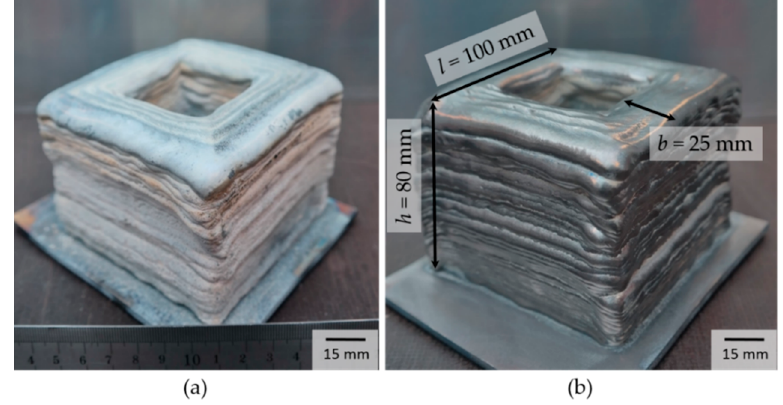
Figure 3. Manufactured part ( a ) as-welded condition ( b ) brushed condition.